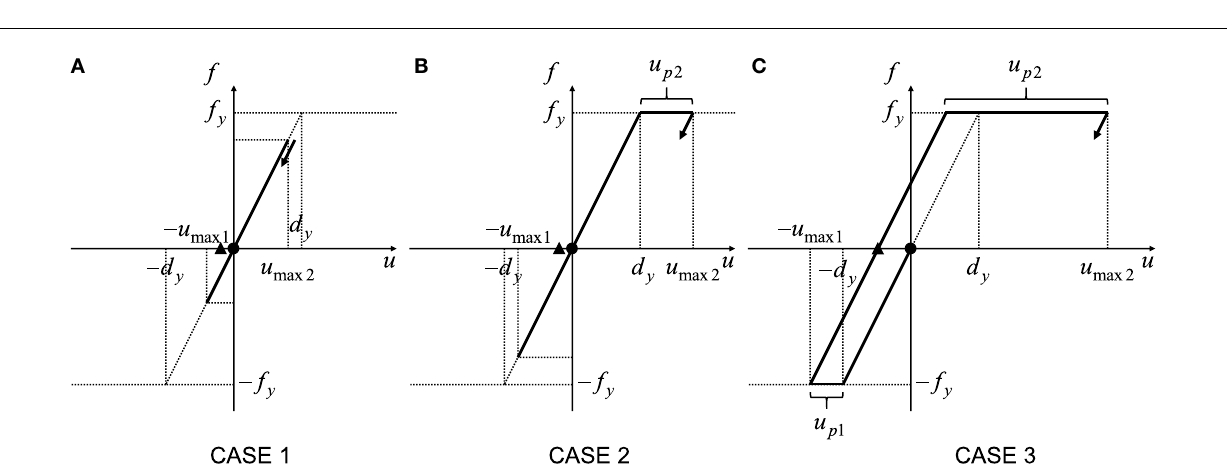
Frontiers in Built Environment |